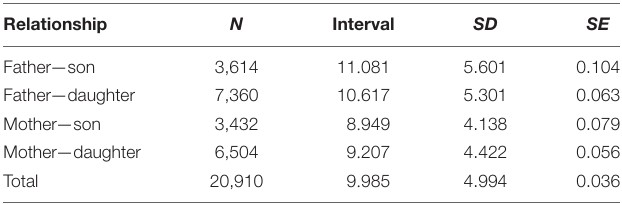
TABLE 4 | Generation interval in the analyzed population, standard deviation (SD), and error (SE). Relationship N Interval